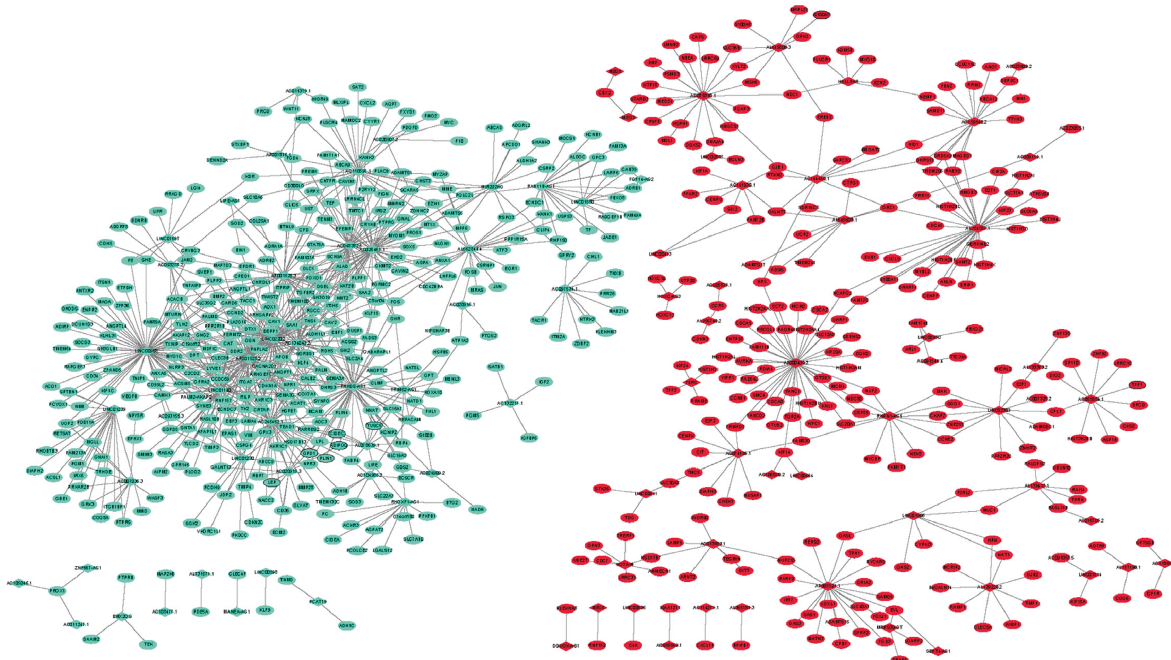
Figure 5: Positively coexpressed DElncRNA-DEmRNA network. Ellipse and rhombus represent DEmRNA and DElncRNA, respectively. Red and green colors represent upregulation and downregulation, respectively. The black border indicates the top 10 upregulated and downregulated DElncRNAs and